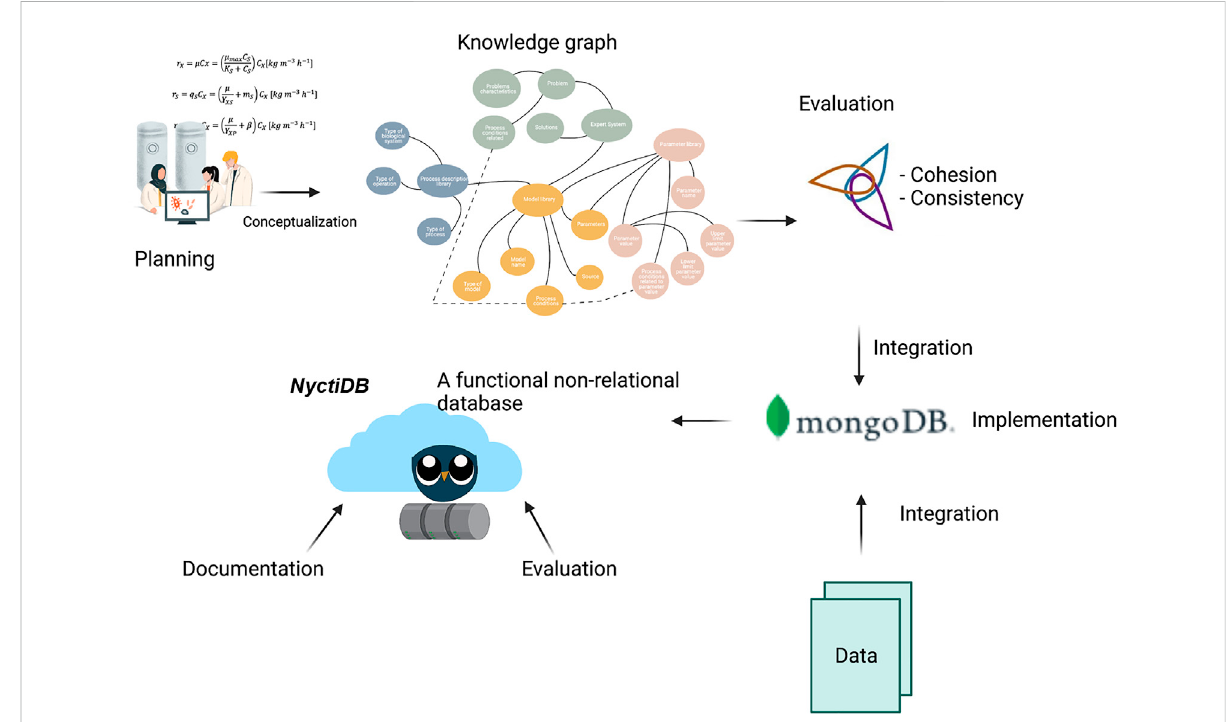
FIGURE 4 NyctiDB ’ s work fl ow:thelinkbetweentheontology andthenon-relational database.Moreinformationabouttheknowledge graphcanbeseen in Figure